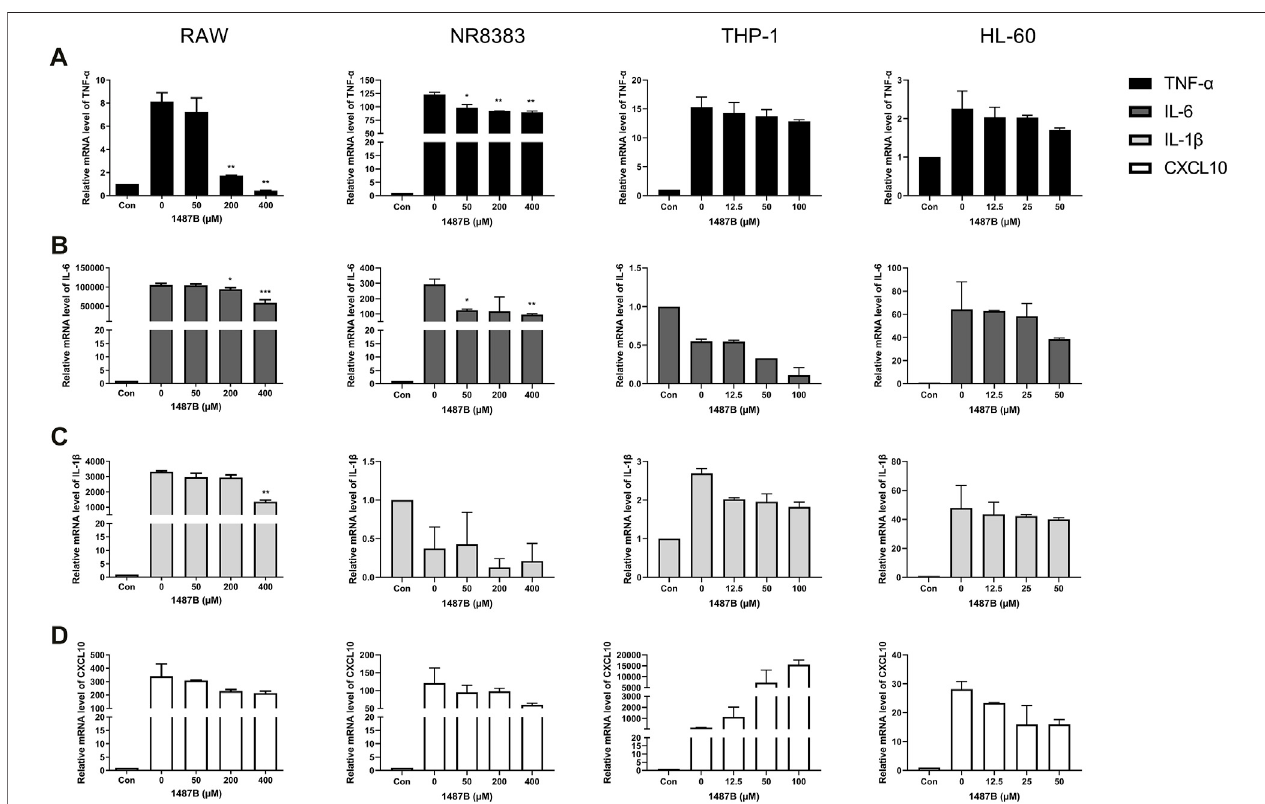
FIGURE 5 | 1487B inhibits the expression of TNF- α , IL-6, IL-1 β , and CXCL10 in macrophages. RT-PCR quantitation of TNF- α (A) , IL-6 (B) , IL-1 β (C) and CXCL10 (D) mRNA expression in RAW and NR8383 cells stimulated with LPS (100 ng/ml) following treatment with 50, 200, and 400 µM 1487B, and in THP-1 cell stimulated with LPS (100 ng/ml) following treatment with12.5, 50, and 100 µM 1487B, and in HL-60cell stimulated with LPS (100 ng/ml) following treatment with12.5, 25, and 50 µM 1487B. (mean ± SD, n (cid:1) 3) * p < 0.05, ** p < 0.01, *** p < 0.001 vs. LPS-induced group.